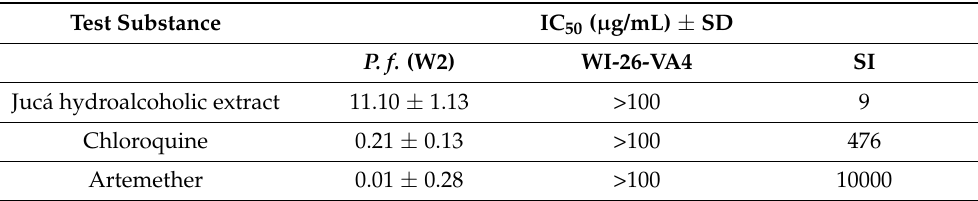
Table 2. In vitro results for antiplasmodial activity (IC 50 ) of Jucá hydroalcoholic extract against P.